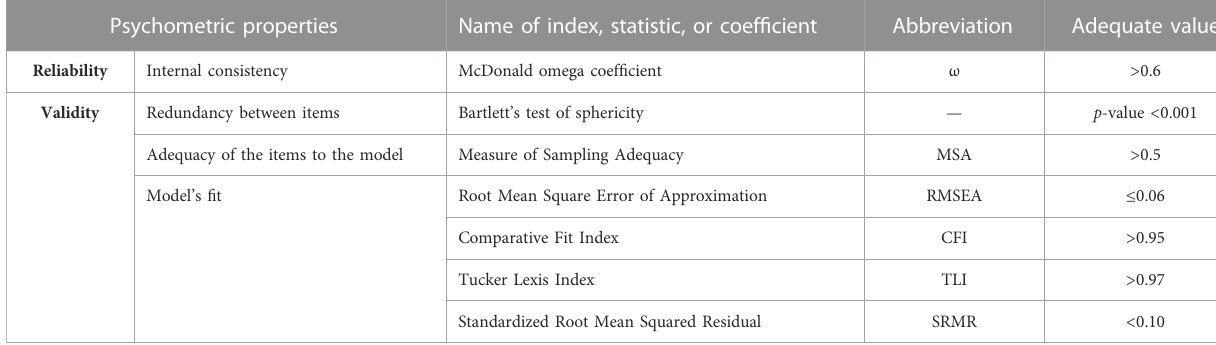
TABLE 1 Indexes, statistics, and coef fi cients used to assess the reliability and validity of the